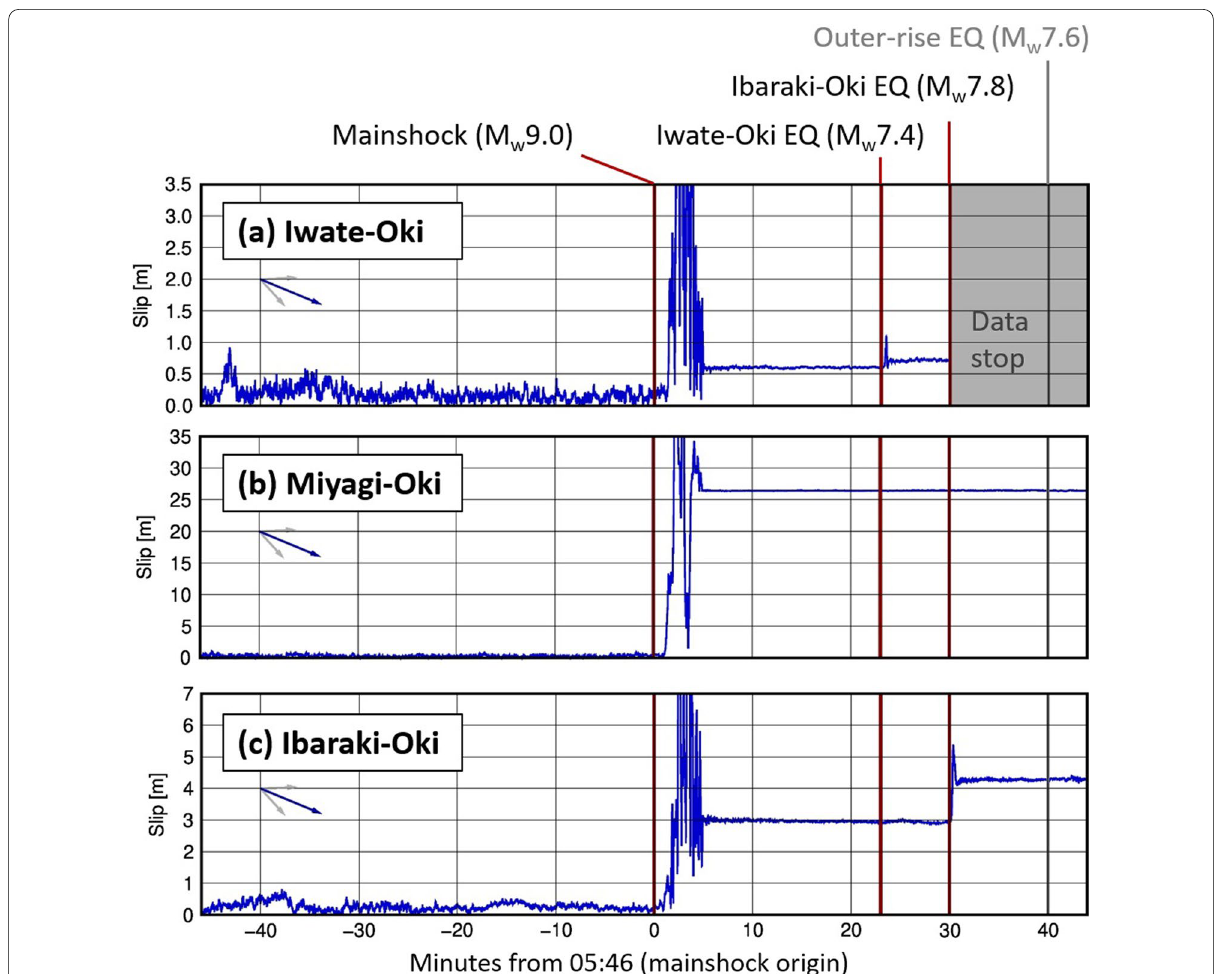
Fig. 2 Examples of the estimated slip time series. Now, we show time series for three subfaults near the hypocenter of the Iwate-Oki EQ ( a ), mainshock ( b ), and Ibaraki-Oki EQ ( c ), as indicated by black squares in Fig. 1. The figures describe the slip time series calculated from the estimated values of two slip basis. All figures cover the whole analysis period and use GPS Time. Vertical lines indicate the origin time of the mainshock and three significant aftershocks. Please note that the scale of the vertical axis differs for each